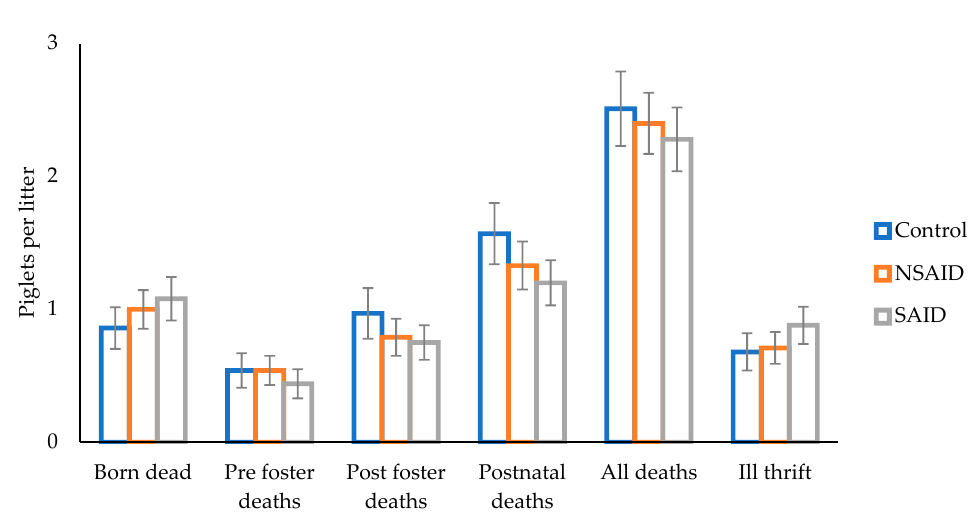
Figure 3. The effect of saline (Control), a non-steroidal anti-inflammatory (NSAID), or steroidal anti-inflammatory (SAID) administration prior to farrowing on piglet deaths recorded at birth, prior to fostering, after fostering, postnatal deaths (the sum of pre and post foster deaths), all piglet deaths (the sum of piglets born dead and postnatal deaths), and piglet removal for ill thrift from sows (mean ± SEM).